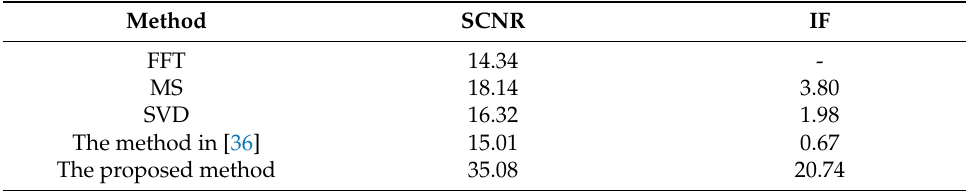
Table 3. Quantitative results of the through-wall detection.